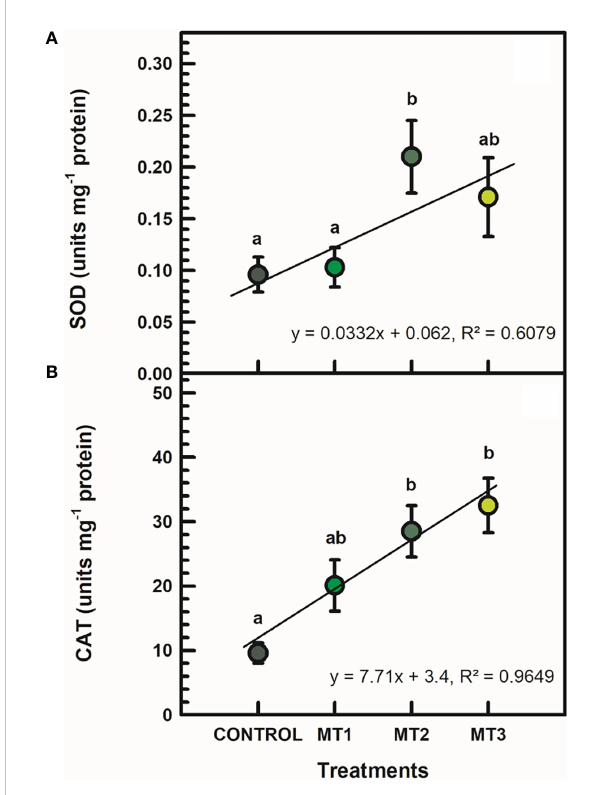
FIGURE 5 Superoxide dismutase (SOD) ( A ; units mg -1 protein) and catalase (CAT) ( B ; units mg -1 protein)activities in fl owers of tuberose plants treated with preharvest foliar applications of distilled water (control; MT0) and three concentrations of melatonin (MLT): 0.05 mM (MT1), 0.07 mM (MT2), and 1 mM (MT3). Data are means ±SE (n=40). Different letters above the bars indicate signi fi cant differences according to the LSD test at